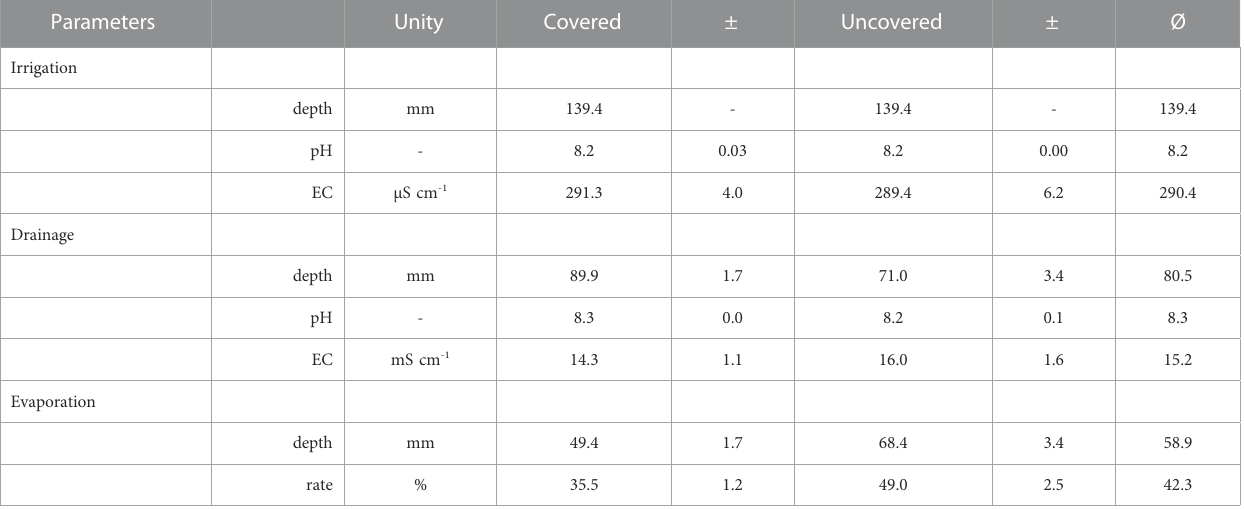
TABLE5 Waterbalanceanddrainagepropertiesofthecoveredanduncoveredcolumnsfrom15.01.2015to14.05.2015.Valuesarepresentedasmeans±standard deviation. Parameters Unity Covered ± Uncovered Irrigation